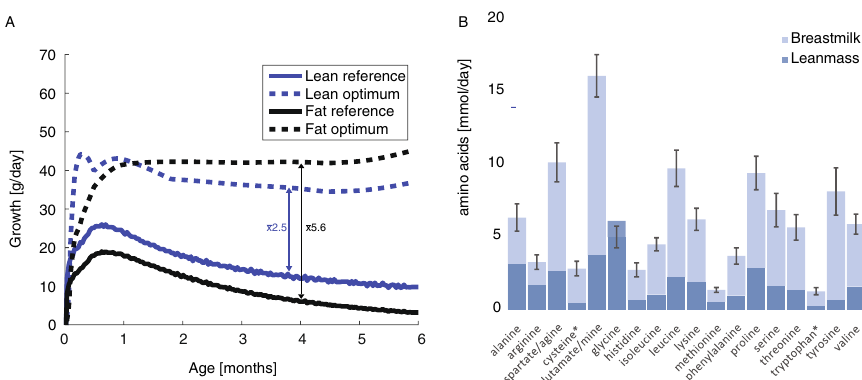
Fig. 2 Energy is the main growth limiting factor. a Simulations were run with the energy for maintenance and activity set to zero. The optimal growth of lean and fat mass at each time point was calculated in 2 independent simulations and compared to reference data, calculated from the weight increment 3 and the interpolated distribution between fat and lean mass. 15 The maximum possible growth was on average 2.5 and 5.6 times higher than the reference growth for lean and fat mass respectively. The smallest difference between maximum and reference growth occurred from birth to age 2 months. b At 1 month age, the uptake of all amino acids from milk was higher than the amount of stored amino acid, except for the nonessential amino acid